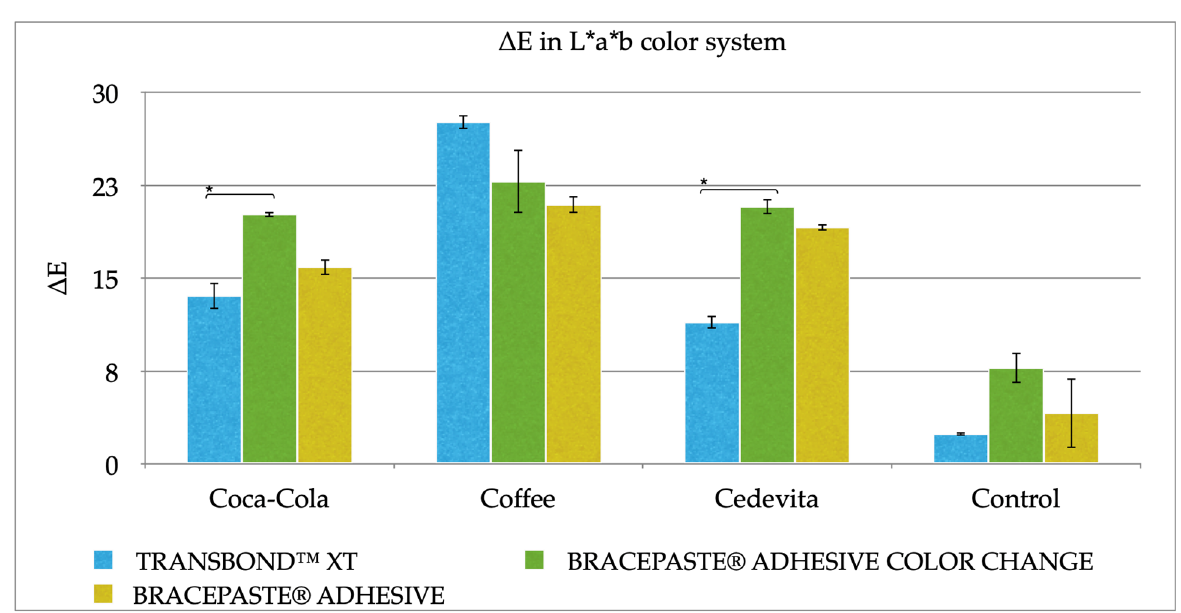
Figure 3. Color change values ( Δ E*) of adhesive samples after 14 days of immersion. * statistically significant difference p < 0.05.